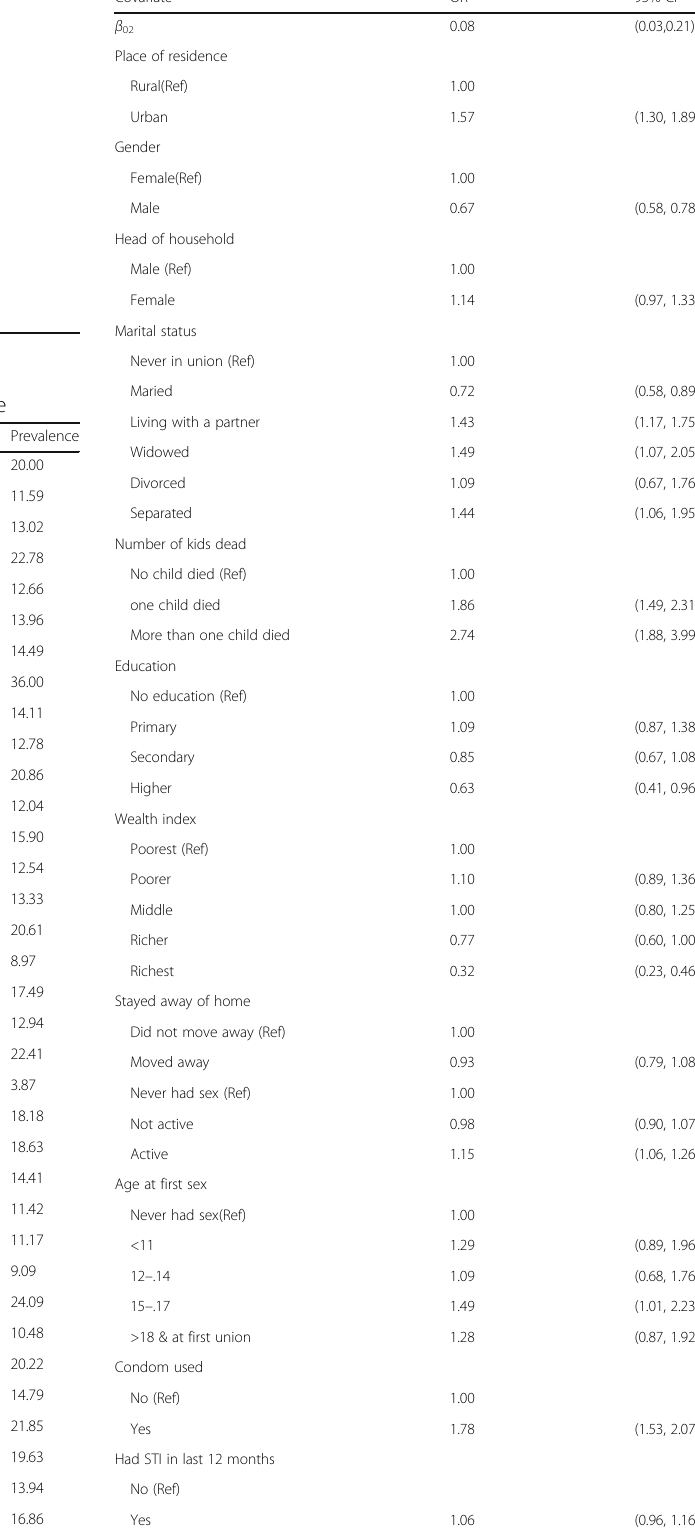
Table 5 Observed HIV prevalence per constituency and per gender (Continued)